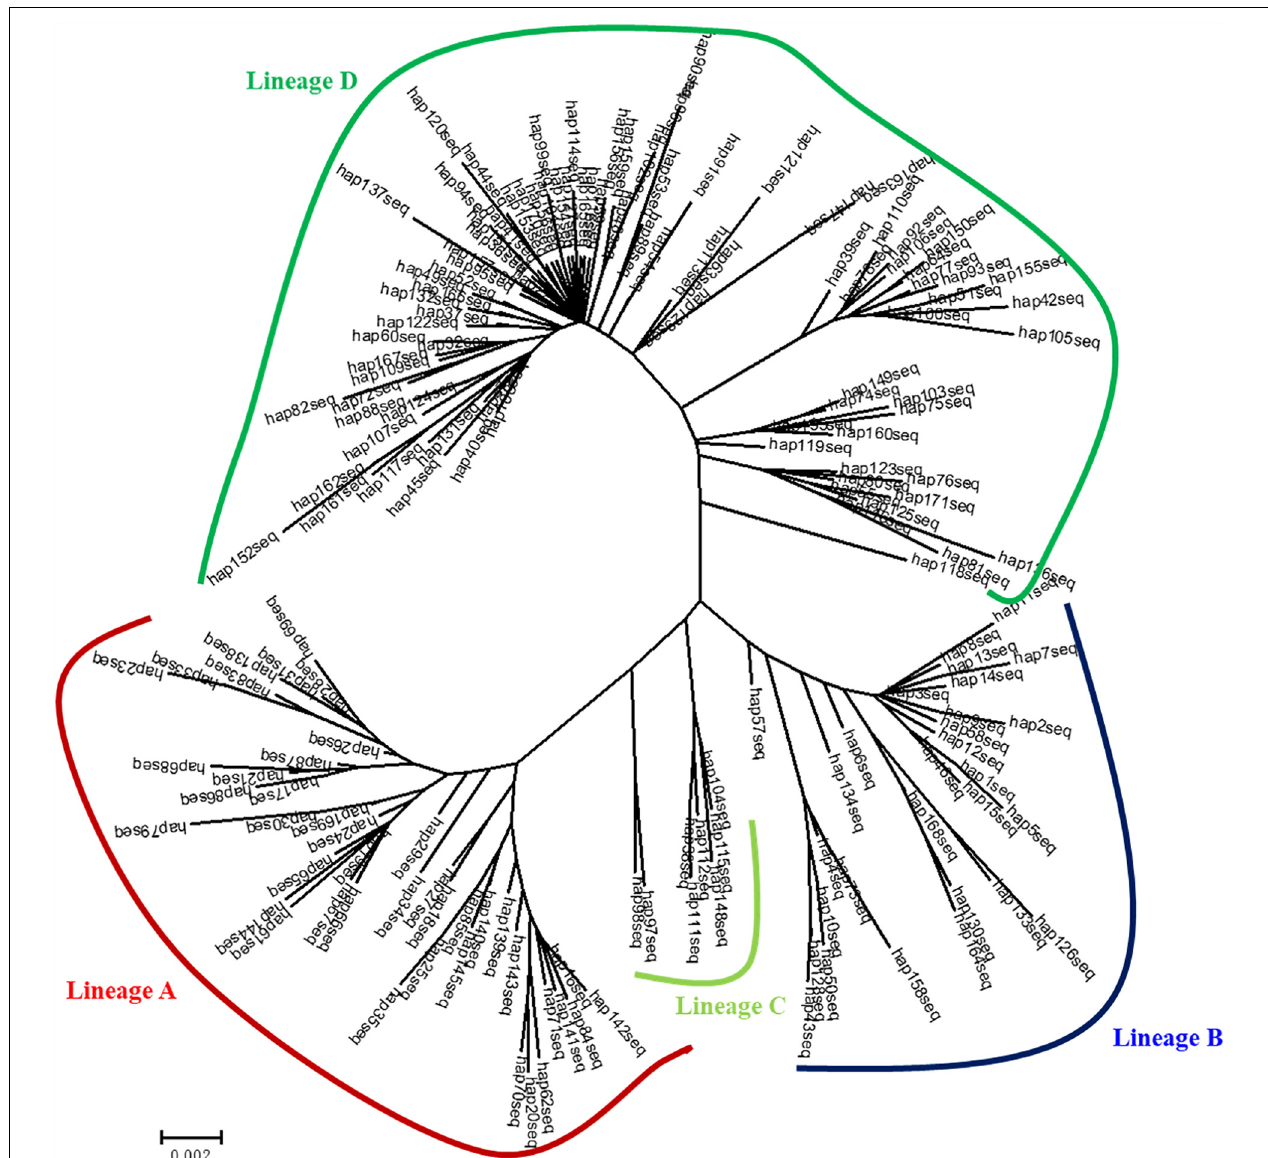
FIGURE 2 | Bayesian tree for mtDNA D-loop haplotypes for C. nasus constructed under the HKY + I + G model using MRBAYES. Numbers above branches show posterior probabilities of nodes.